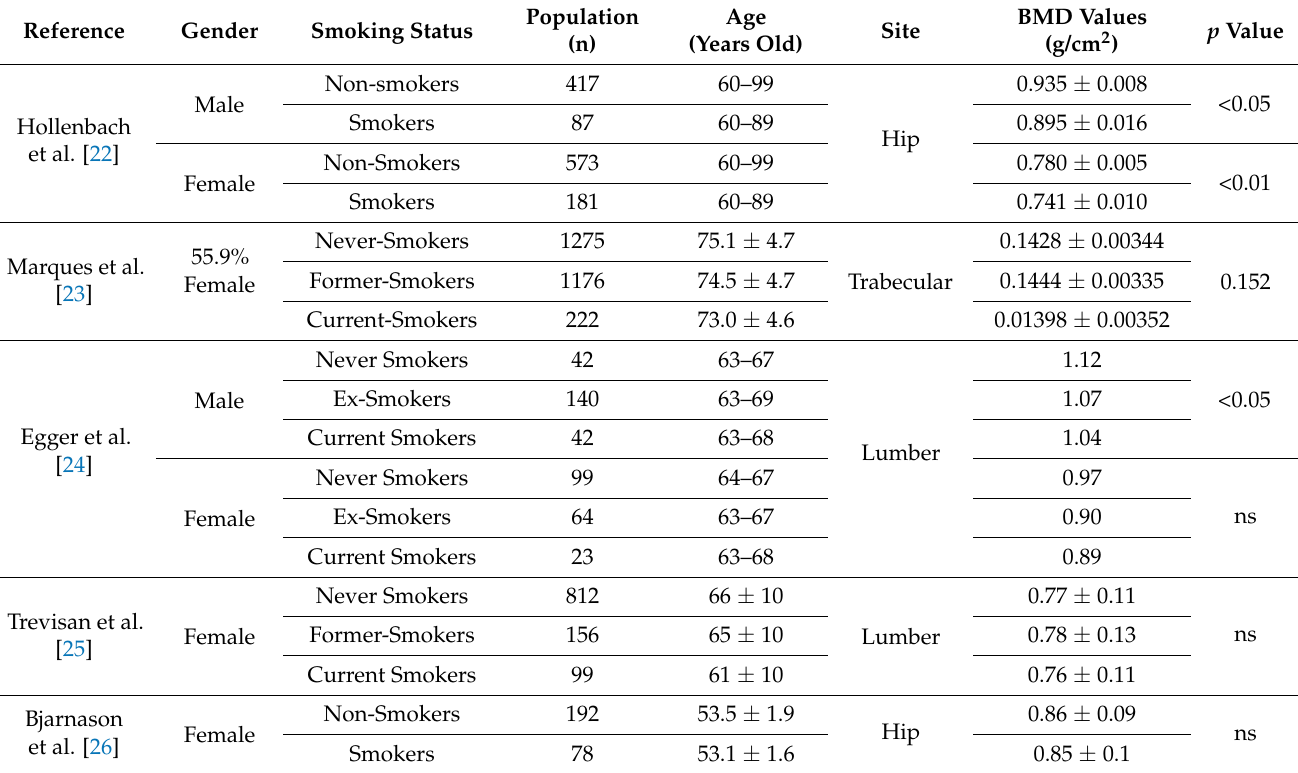
Table 1. Clinical studies of cigarette smoking in relation to